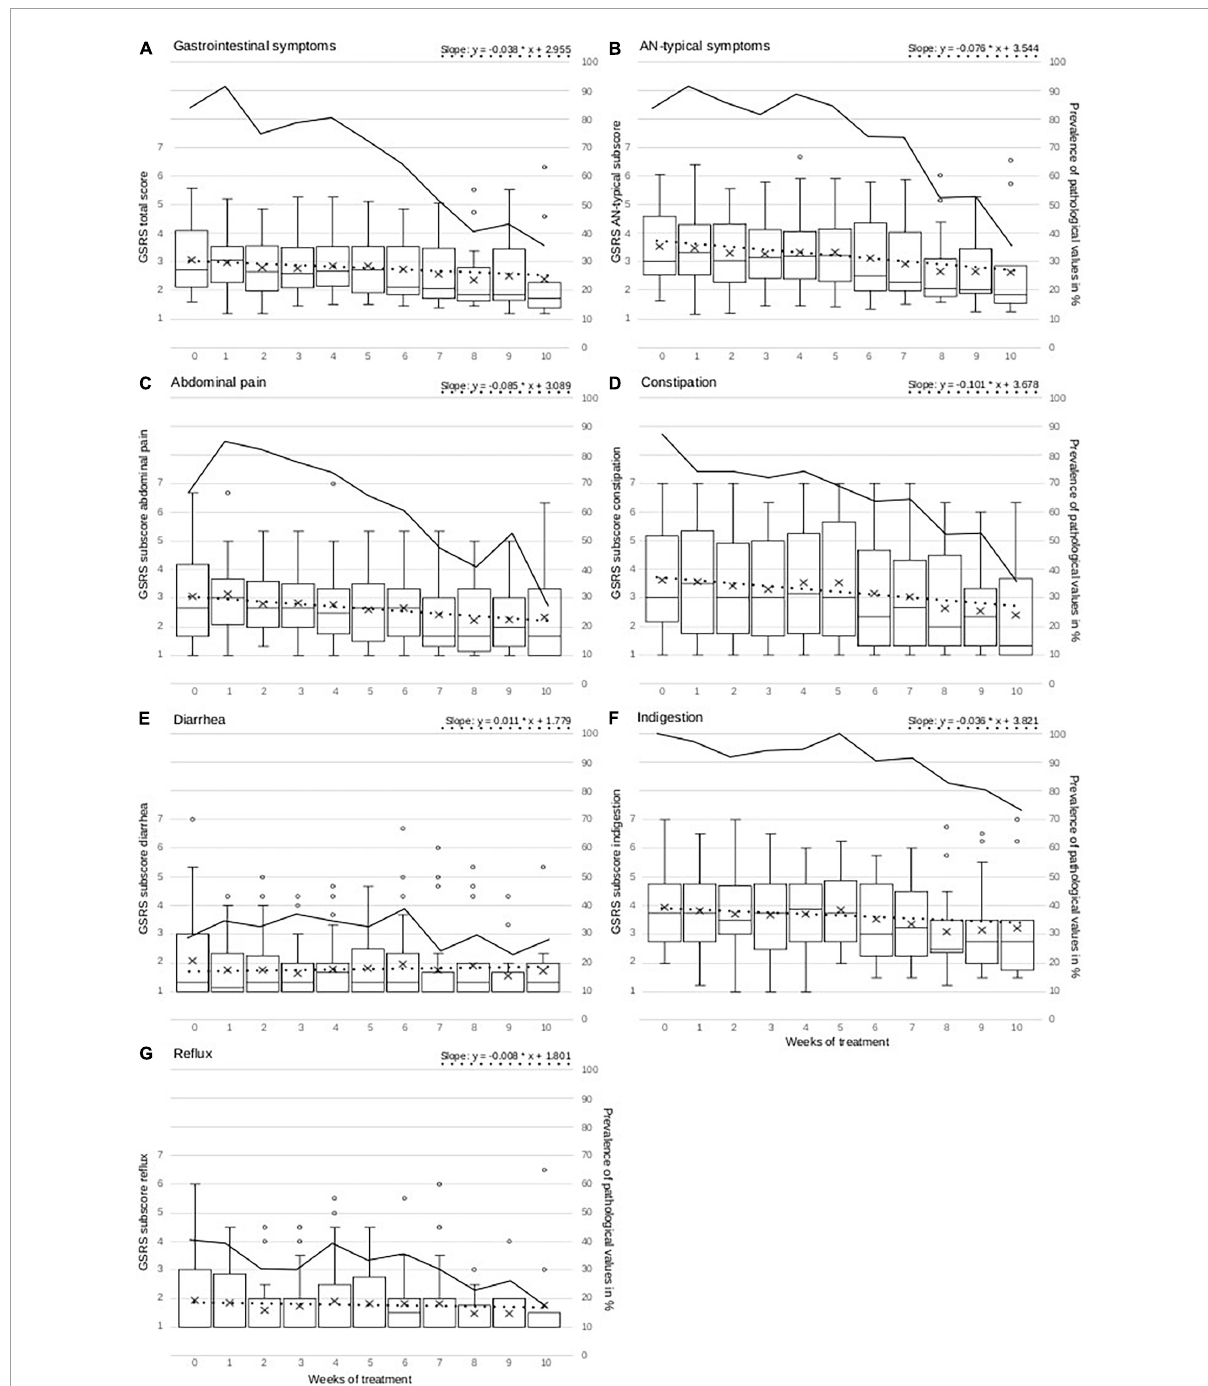
FIGURE1 Figure presents weekly measurements of overall GI symptoms, AN-typical GSRS score and GSRS subscales abdominal pain, constipation, diarrhea, indigestion, and reflux as boxplots with mean (+), median (–), interquartile range (IQR = box), whiskers (1.5 × IQR), and outliers (o > 1.5 IQR). The y-axis for all GSRS scores is located on the left of each graph. The dotted line represents the development estimated by mixed linear models for each GSRS score. The mathematical function for this development estimated by mixed linear models is given in the upper right of each separate graph and is constructed with the estimate at admission and the weekly GI change (also see Table 2 ). In this formula, the x value can be replaced by the treatment week in order to calculate the corresponding estimated GSRS score, which is represented by the y value, for this specific treatment week. The formula is derived from the mixed linear model results, which are presented in Table 2 . The continuous line represents the development of the prevalence of pathological GSRS values in % within the examined population. The y-axis of the prevalence is located on the right side of each